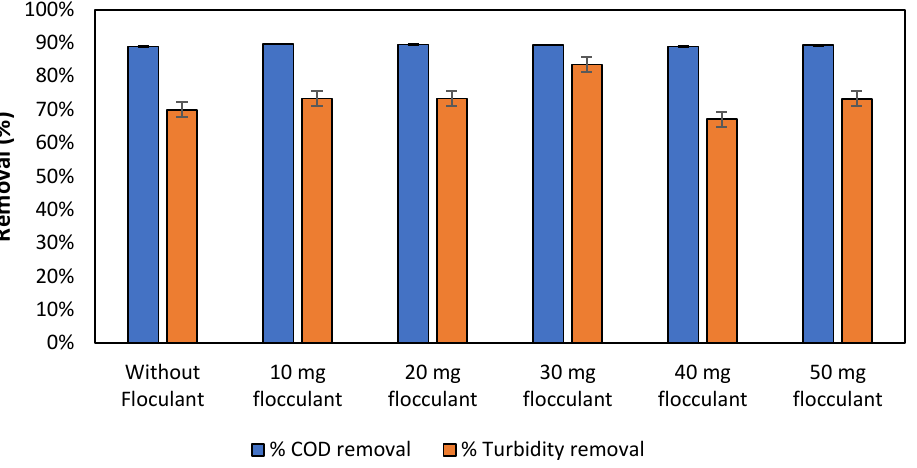
Figure 3. Removal of COD (%) and turbidity (%) from anaerobic centrate after Fe 3 O 4 (s)/SiO 2 (s) ad- dition.